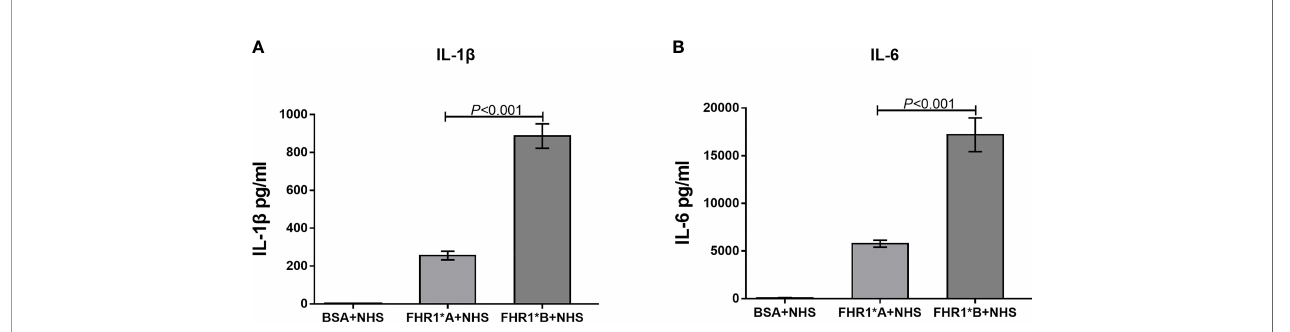
FIGURE 6 | FHR1 induces monocytes to secrete in fl ammatory cytokines. Compared to BSA, both FHR1*A and FHR1*B signi fi cantly increased IL-1 b (A) and IL-6 (B) secretion by monocytes. In addition, FHR1*B induced the secretion of higher levels of IL-1 b (A) and IL-6 (B) by monocytes than FHR1*A. The data are presented as the means ± SDs. The results are representative of three independent experiments. The data are presented as the means